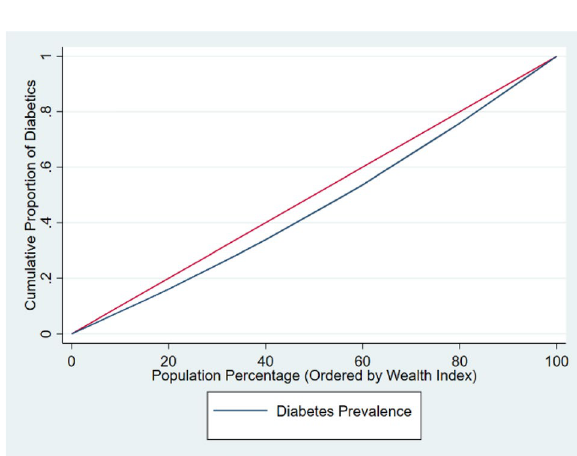
Figure 3. Adjusted concentration curve for diabetes prevalence in India, 2019–2021.